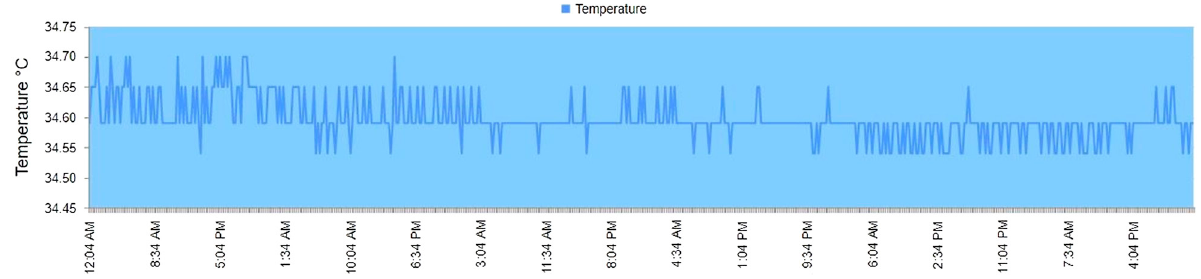
Figure 3. Detailed analysis of the temperature graph for one microsensor in the thick Hawley retainer group, with a temperature range between 34.54°C and 34.70°C.